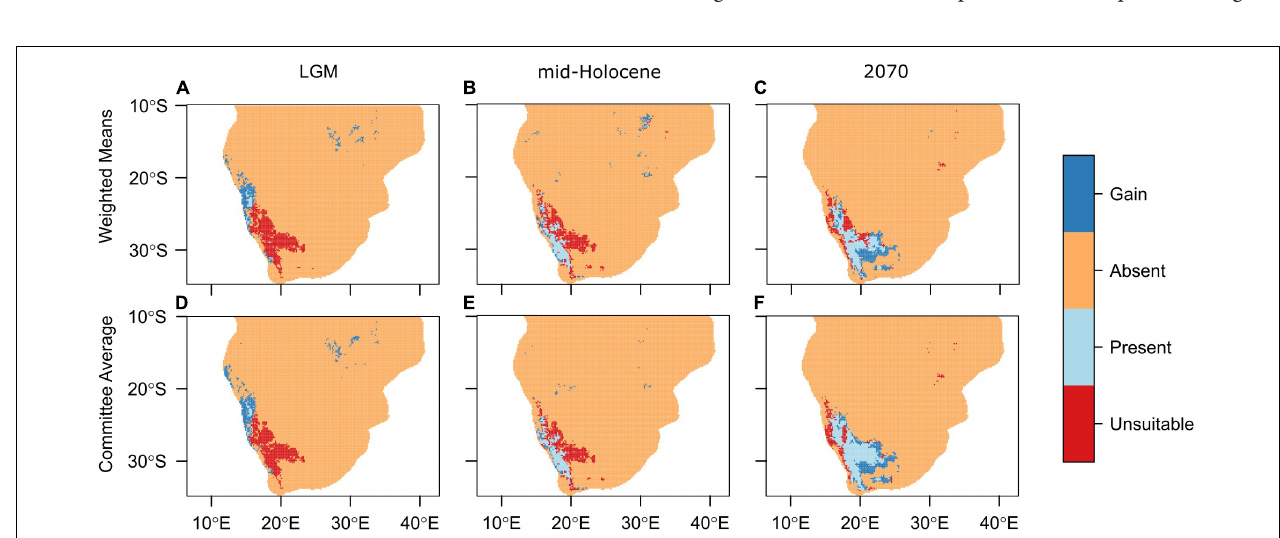
FIGURE 2 | Projected ranges of Aloidendron dichotomum for the (A,D) Last Glacial Maximum (22,000 years BP), (B,E) mid-Holocene (6,000 years BP), and (C,F) 2070. Ensemble models were computed using the (A–C) weighted means and (D–F) committee averaging methods using the CCSM4 global circulation model. Orange regions denote areas where the species is absent; dark blue where it has gained range; light blue where it has remained present when compared to current range projections; and red where range is unsuitable when compared to current range.